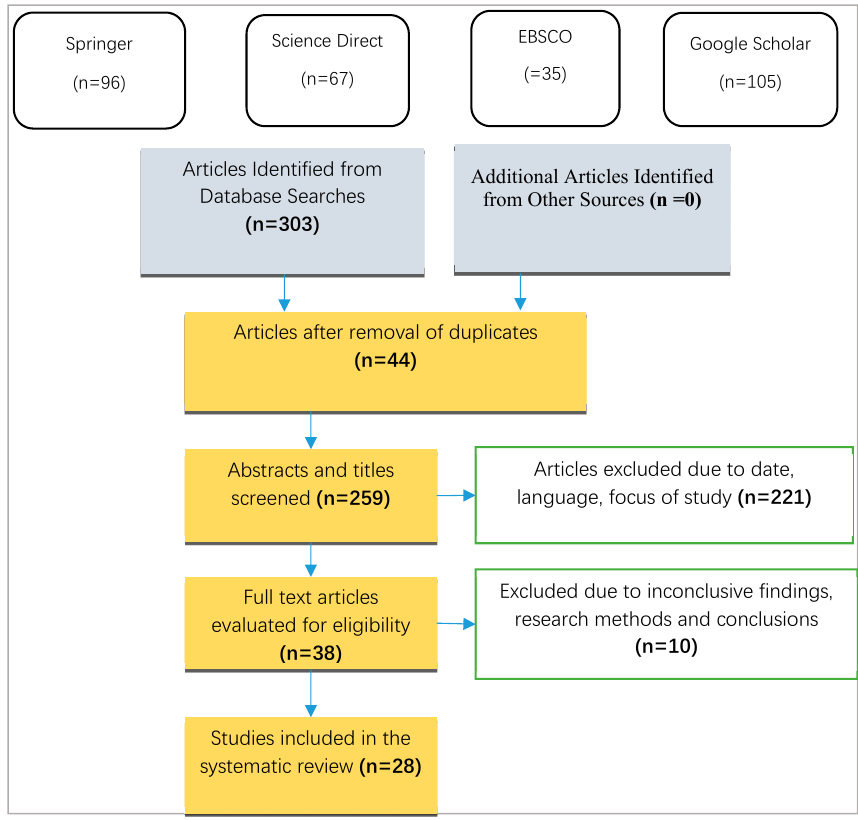
Figure 1. The Preferred Reporting Items for Systematic Reviews and Meta-Analyses (PRISMA) flow